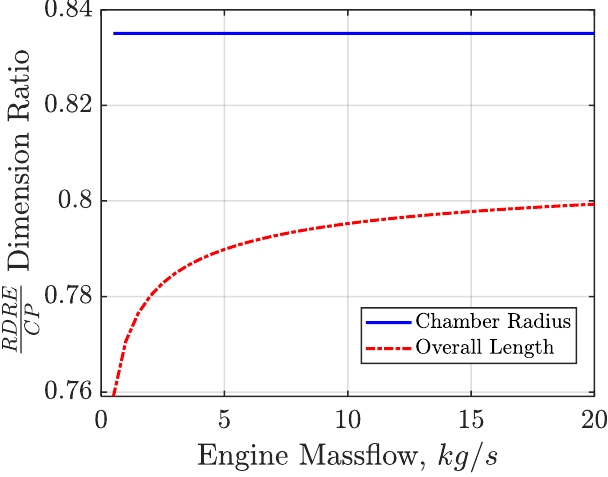
Figure 7. Comparison of envelope dimensions between RDRE and CP chambers.